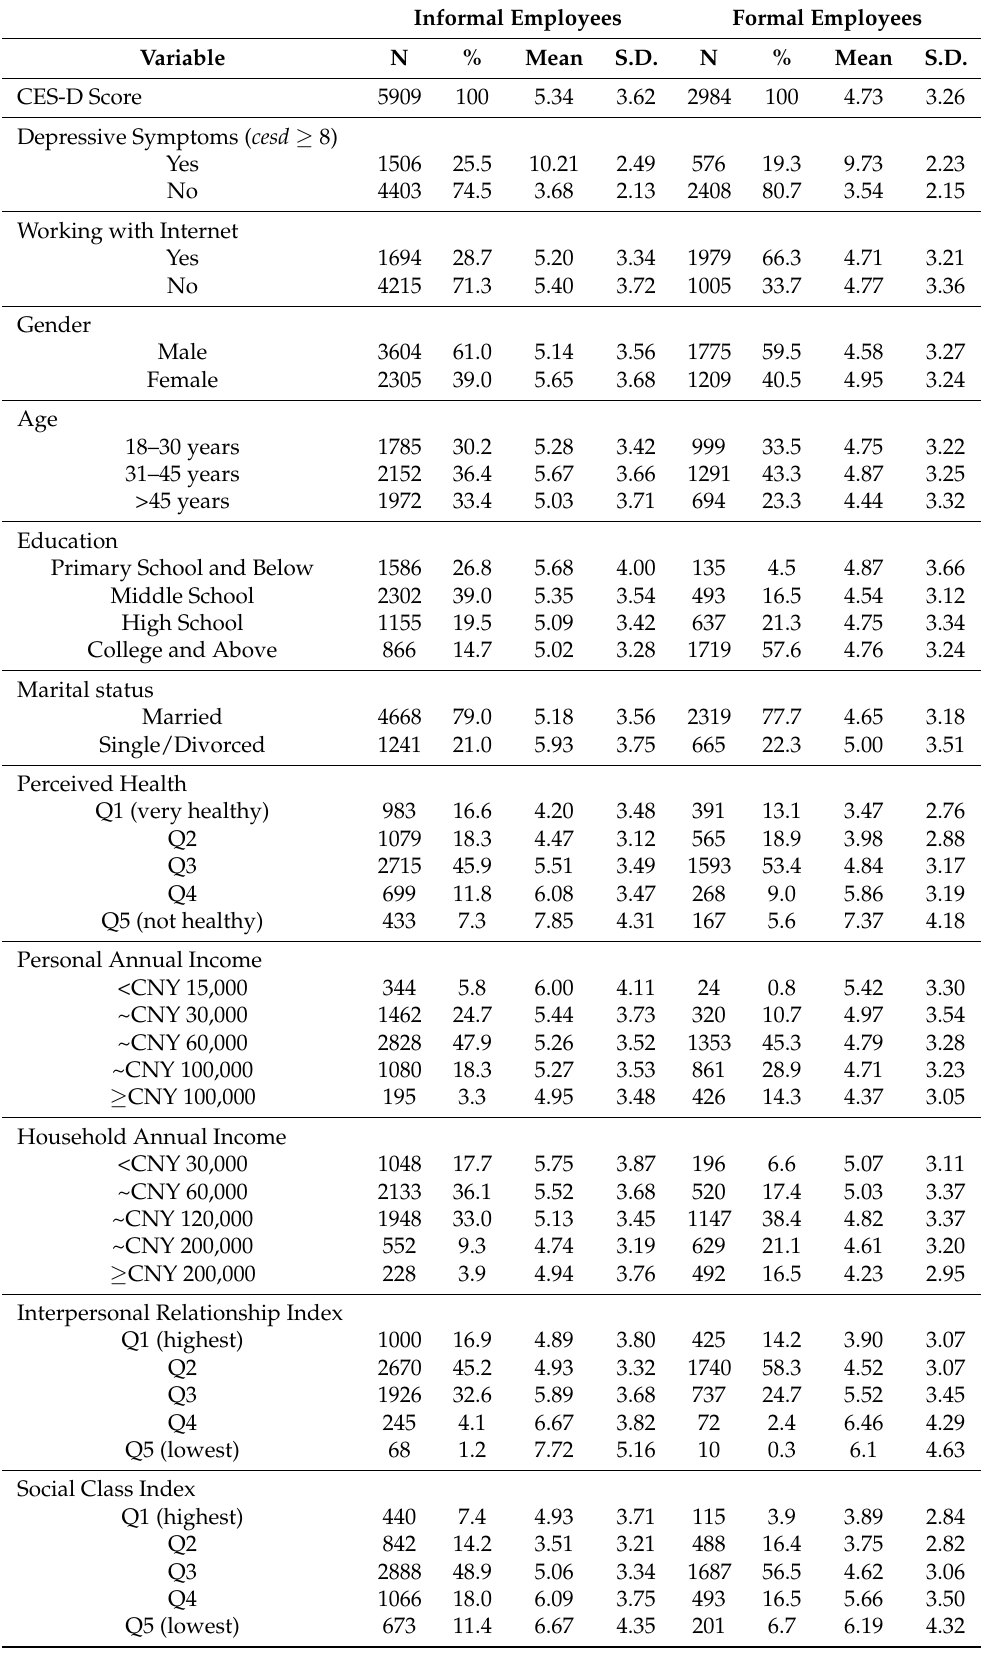
Table 2. General statistics and CES-D score of the grouped